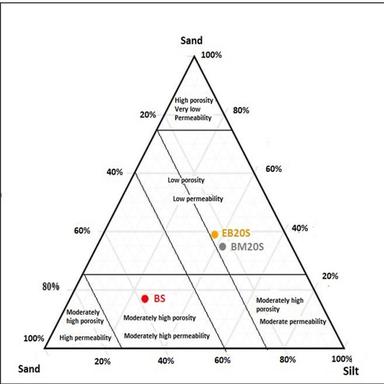
Ternary diagram of studied clay following the relation between sand, silt, and clay components and their controls over porosity and permeability, after McManus (1988).